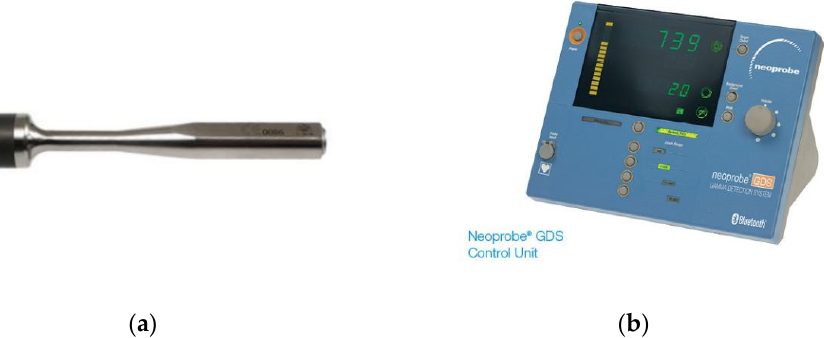
Figure 2. PET Probe System for clinical intra-operative use. ( a ) Hand-held probe capable of detecting high-energy photons, ( b ) Neoprobe gamma detections system control unit with gamma counts per second (cps) readout (Mammotome, Cincinnati, OH,